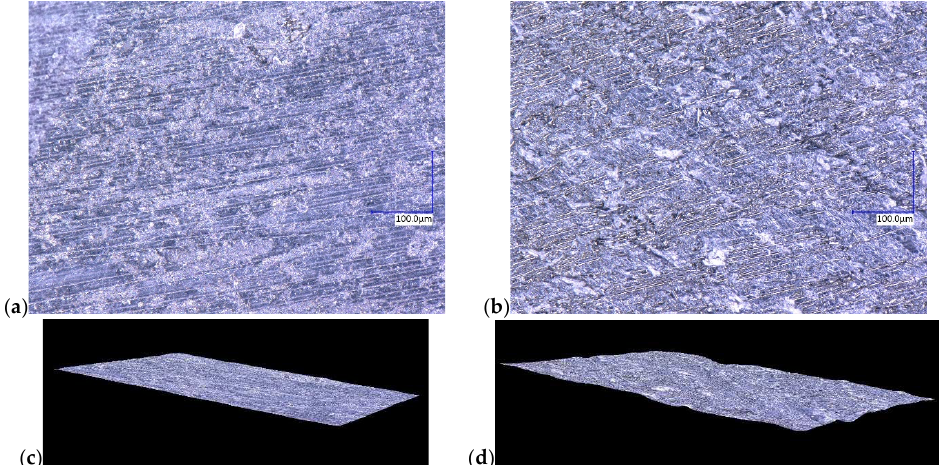
Figure A2. Profilometer image of the composite surface ( a , c ) before and ( b , d ) after grinding treatment before welding.